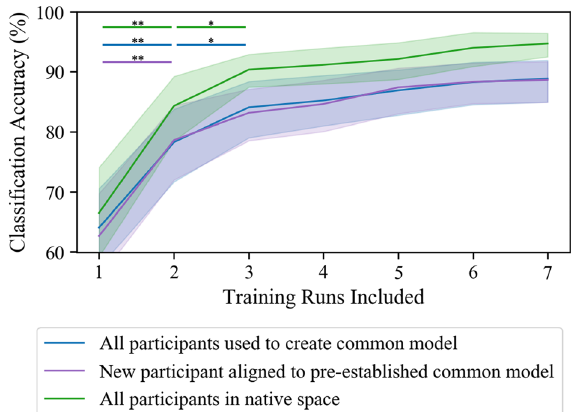
Figure 8. Number of runs needed to hyperalign individuals and train an accurate classifier. The results indicate that at least two runs are necessary to accurately align a new participant to a pre-established common model. At least three runs are necessary for the between-subject classifier using all participants to create the common model and the within-subject classifier trained in a subject’s native space. Shaded outline indicates 95% confidence interval. * p < 0.05, ** p <